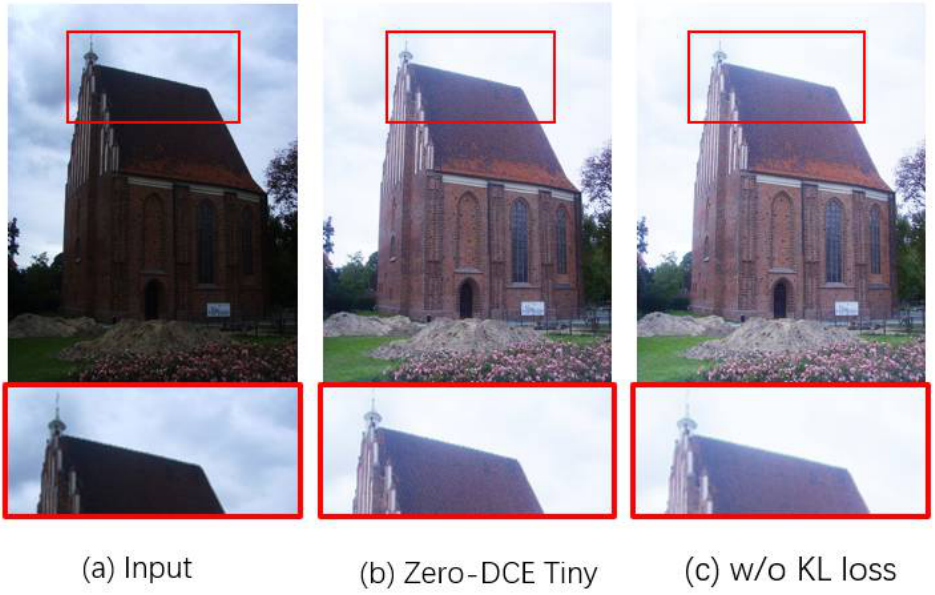
Figure 6. Sensory comparison of kl loss ablation experiment. Subfigure ( a ) shows the original input, subfigure ( b ) shows the enhanced image result through Zero-DCE Tiny method, subfigure ( c ) shows the image enhancement result after removing channel consistency loss.